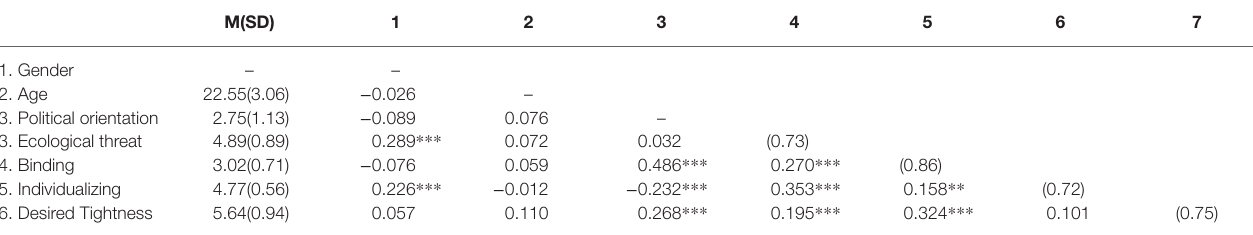
TABLE 5 | Summary of means, standard deviations, and correlations between variables, Study